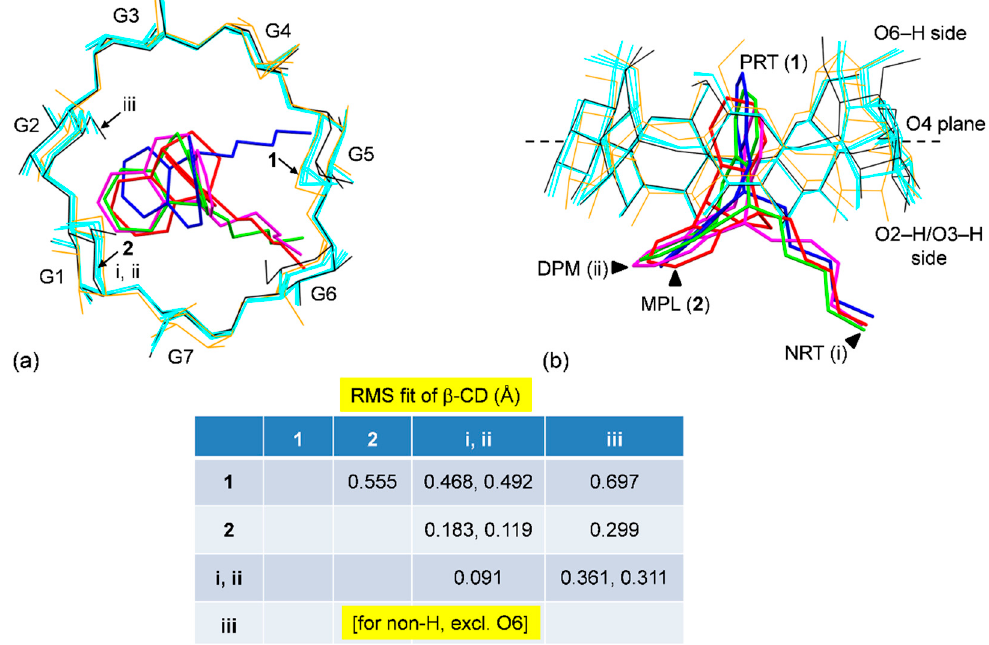
Figure 6. Structure superpositions of four β -CDs (orange and cyan wireframes) in complex with various 2° amine TCAs (sticks), PRT ( 1 ; blue), MPL ( 2 ; red), NRT (i; green), DPM (ii; magenta) [23,28], and in the uncomplexed β -CD·12H 2 O (iii; black) [45], viewed from ( a ) the top and ( b ) the side. The rms fits are given in the middle inset.